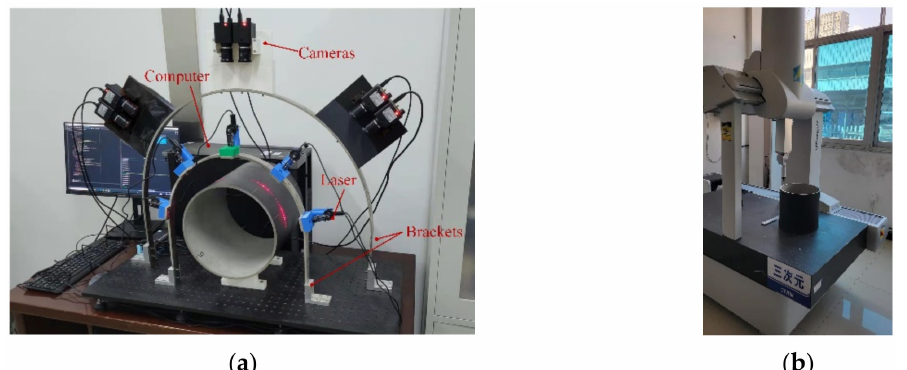
Figure 9. Fitting-error distribution for diameter.